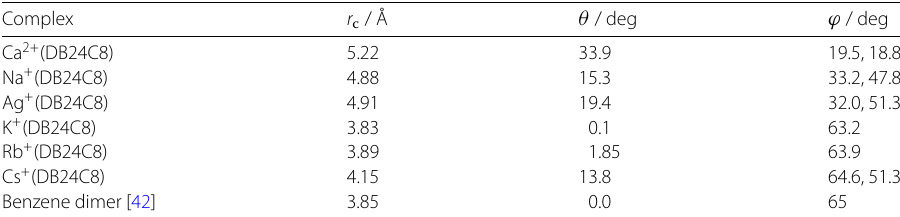
Table 4 Parameter values of benzene ring positional relationship in stable closed conformers for M(DB24C8) (M = Ca 2+ , Na + , Ag + , K + , Rb + , Cs + ) and benzene dimer Complex r c / Å θ / deg ϕ / deg Ca 2+ (DB24C8) 5.22